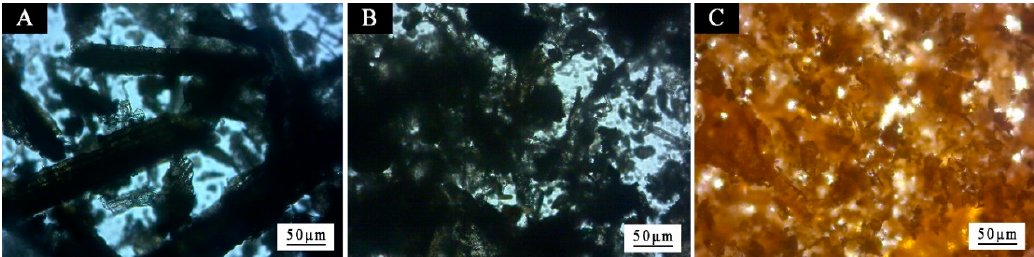
Figure 10. Digital microscopic images of ( A ) wheat straw powder, ( B ) WSPALR, and ( C ) high-temperature calcined WSPALR.